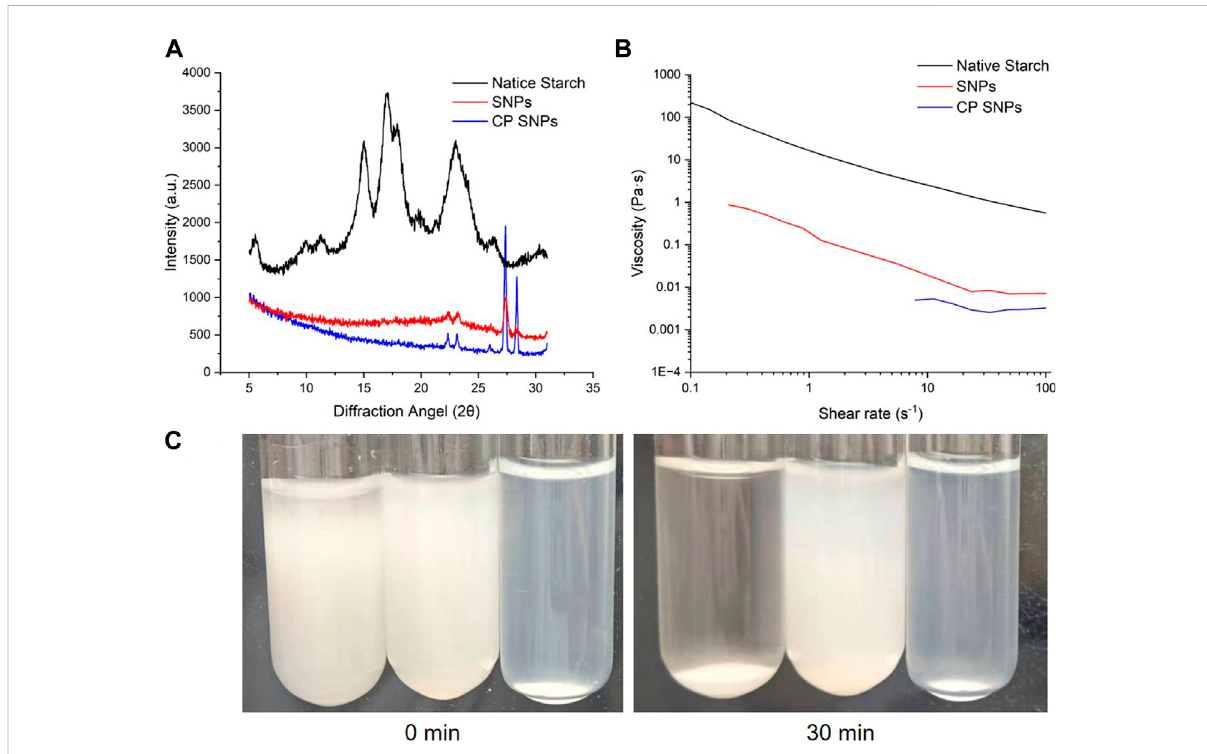
FIGURE 6 Properties of native starch, SNPs and CP SNPs. (A) X-ray diffraction patterns. (B) Apparent viscosity. (C) Photographs of re-dispersions of native starch (left), SNPs (middle) and CP SNPs (right) in water for 0 and 30 min.